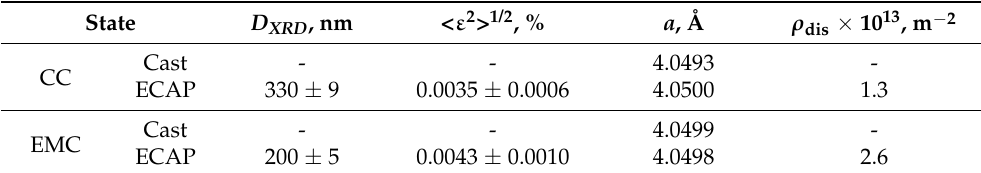
Figure 3. XRD profiles of the CC and EMC Al–1.7Fe alloys in the as-cast states and after ECAP. Table 2. Results of the XRD studies of the CC and EMC Al–1.7Fe alloys in the as-cast state and after